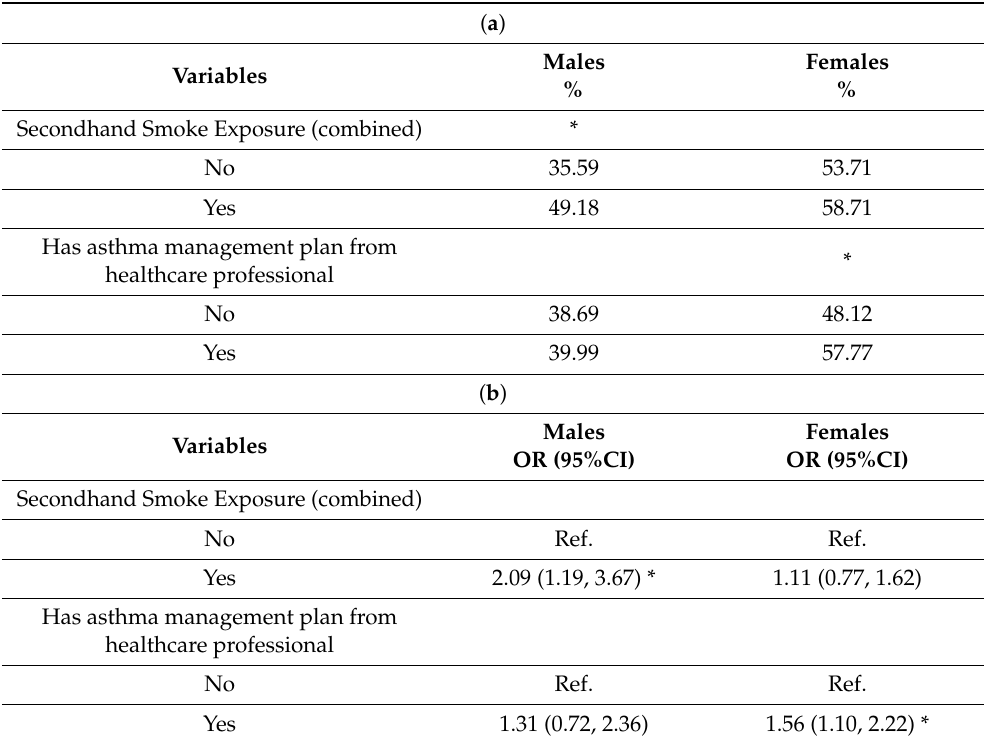
Table 4. a: Prevalence of asthma attack in the past 12 months, by sex, among non-smokers with current asthma. b: Odds ratio (OR) and 95% confidence interval (CI) of asthma attack in the past 12 months, by sex, among non-smokers with current